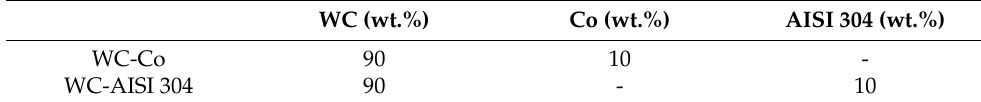
Table 1. Composition of WC-Co and WC-AISI 304 specimens.